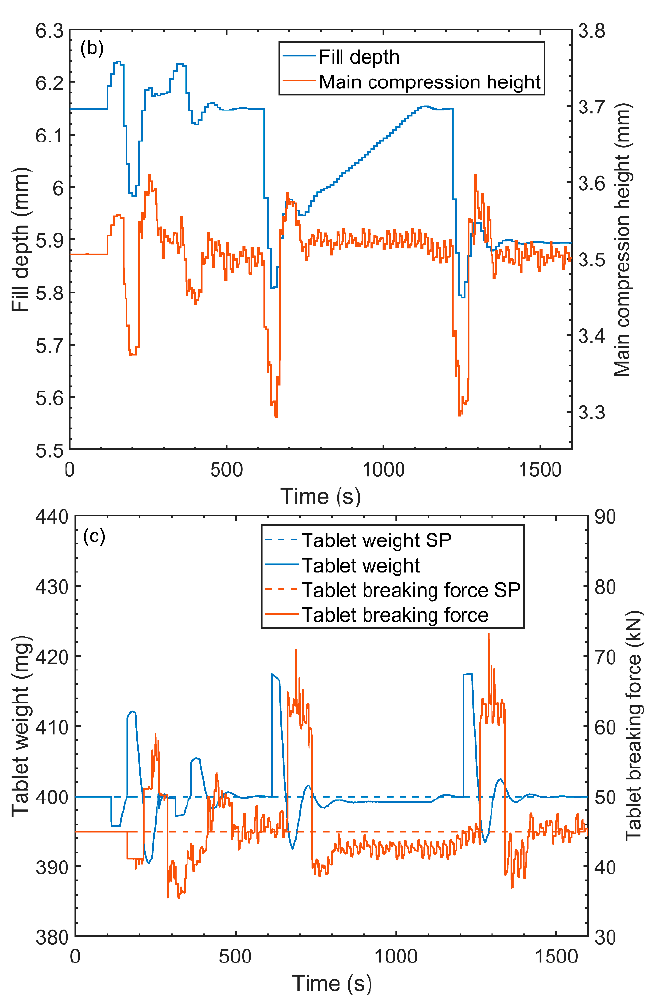
Figure 17. Control strategy 3—Disturbance rejection scenario. ( a ) Critical process parameters ( b ) Actuators ( c ) Critical quality attributes.